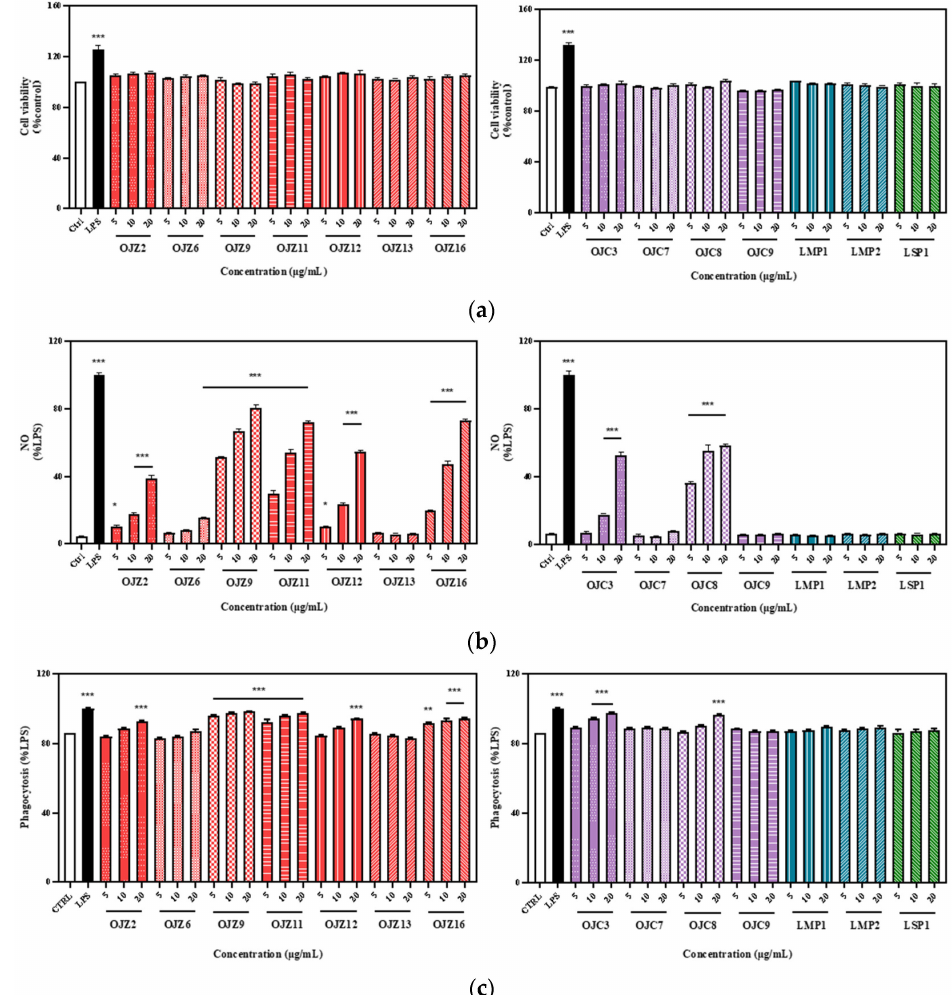
Figure 4. Effects of polysaccharides from representative samples of MaiDong on cell viability ( a ), NO production ( b ), and phagocytosis ( c ) of RAW 264.7 macrophages. All values were expressed as mean ± SEM of three independent experiments. * p < 0.05, ** p < 0.01, *** p < 0.001 vs control group, unmarked results indicate no significant difference vs control group. The codes are the same as